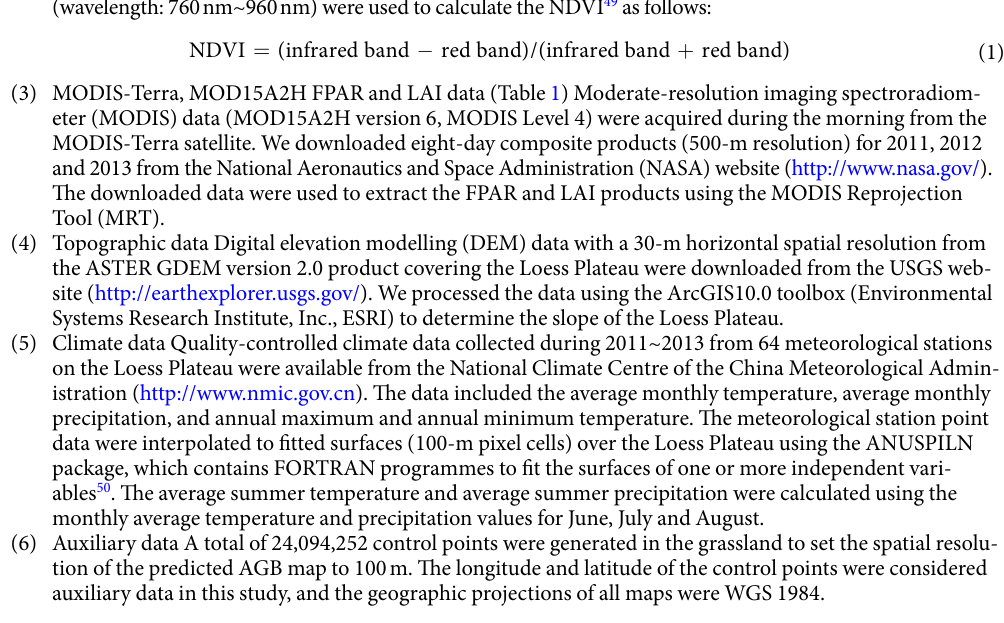
All of the TM data were processed using the quick atmosphere correction within the Environment for Visu- alizing Images (ENVI 5.0) software package. The red band (wavelength: 620 nm~690 nm) and infrared band